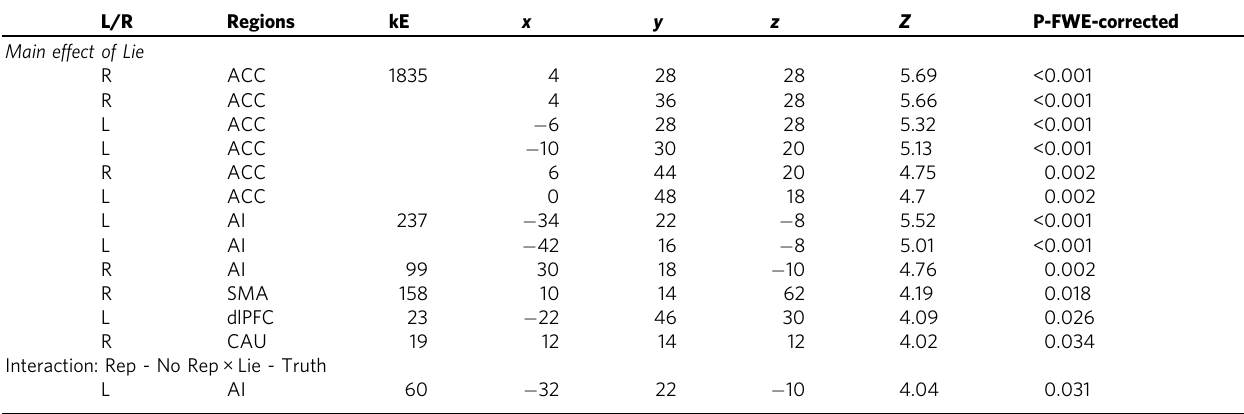
Only clusters and their local maxima that survived family-wise error (FWE) correction ( p <0.05) are presented. L / R left/right, kE numberof voxels, p-FWE family-wise errorcorrected p -value, ACC anteriorcingulatecortex, AI anteriorinsula, SMA supplementarymotor area, dlPFC dorsolateralprefrontalcortex, CAU